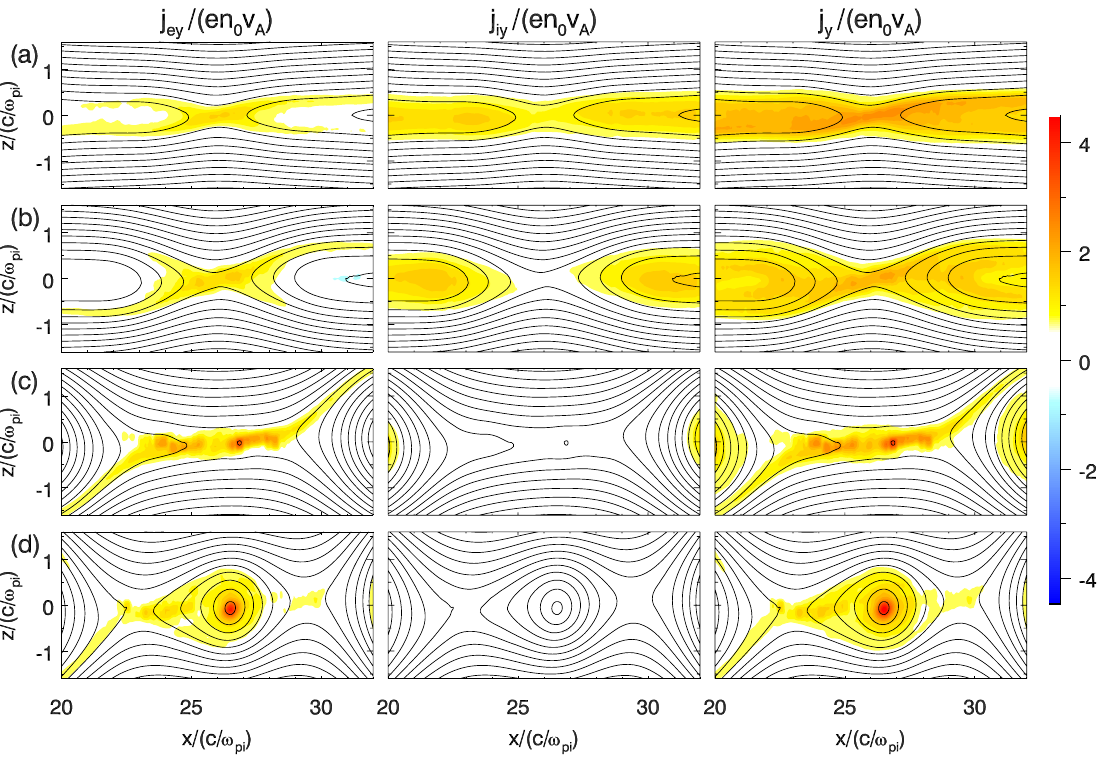
Fig. 1. The time evolution of the current sheet around x = 26 . 6 c (cid:14) ω pi at (cid:127) i t = (a) 18, (b) 22, (c) 29 and (d) 36, respectively. The left, middle and right panels describe the electron current j e y , ion current j i y and total current j y . The magnetic field lines (solid lines) are also plotted for